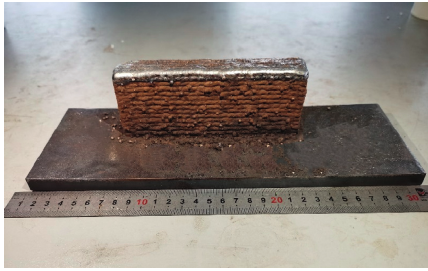
Figure 3: Steel sample prepared in this work by WAAM.